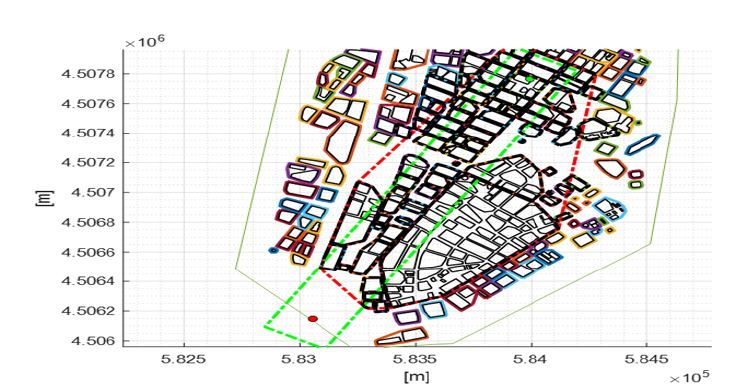
Figure 10. Keep-out geofence polygon extraction for UAS flight planning. The initial ROI (green dashed line) is a rectangular box per Figure 5. Keep-out geofences (solid black lines) inside or intersecting the rectangular ROI box are found using polygon intersection and point-in-polygon operations. The final ROI (red dashed line) is the convex hull around these keep-out geofences. For our simulation, δ ROI = 150